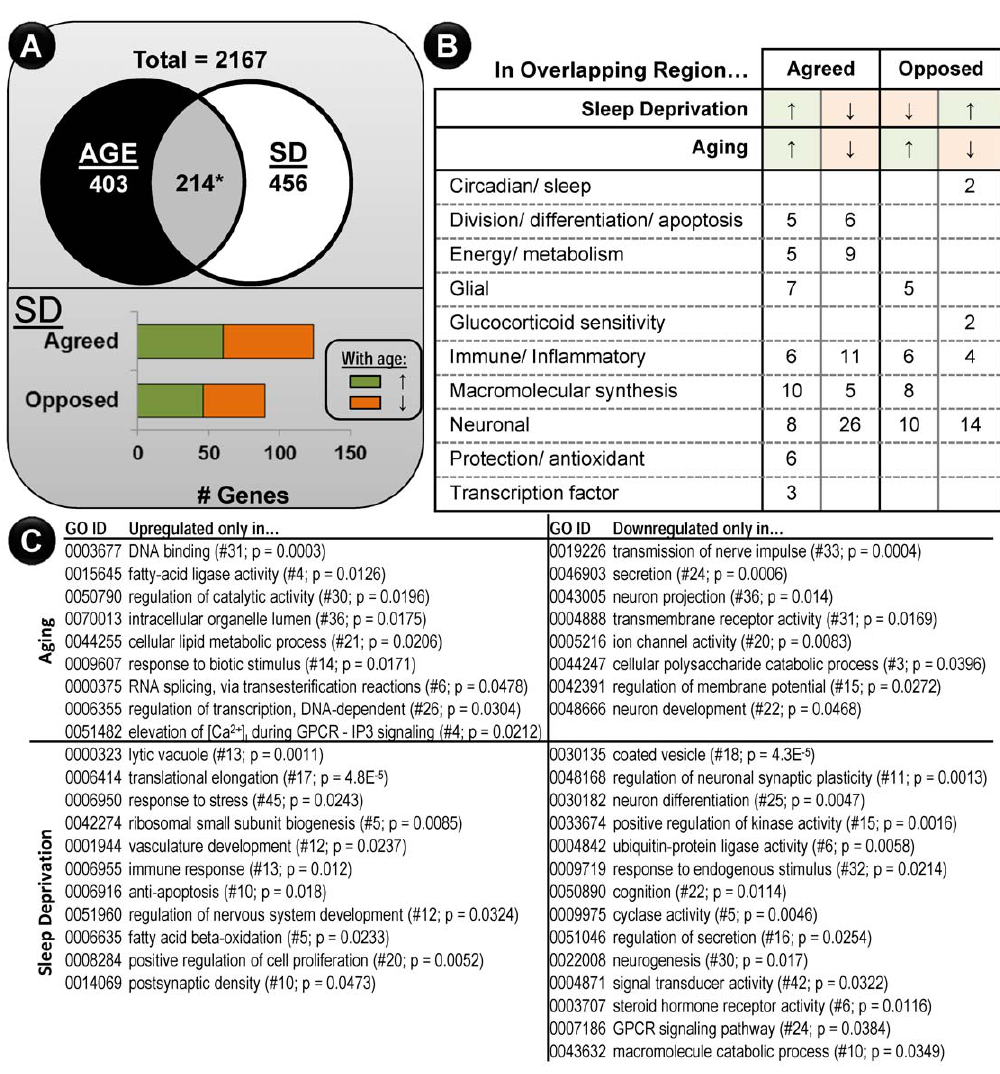
Figure 5. SD and aging influence a similar set of genes. A. Unlike NES (Fig. 4), the significant overlap between aging and SD (* p =0.028, binomial test) contained many genes whose change with age was opposite to that in SD. B. 158/214 genes in the overlap were manually assigned to one of 10 heuristic categories. Because of this approach, no statistical overrepresentation p-values are possible. The number of genes from within each quadrant of the overlap (agreed with SD, aging up, aging down; disagreed in SD- aging up, aging down) are shown. Genes in each category are listed in Results. C. Functional categorization genes regulated exclusively by Aging (upper) or Sleep Deprivation (lower) are separated based on direction of change (Left: Upregulated; Right: Downregulated). (Fig. 4B), and found that the transcriptional magnitude of effect was not significantly different in SD and NES. Therefore, it appears that the NES animals manifested a transcriptional